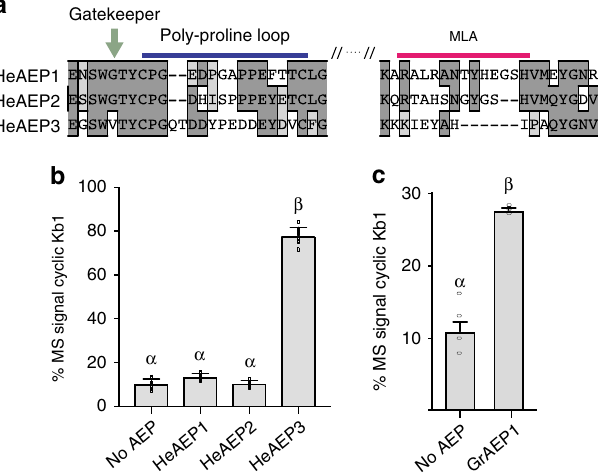
Fig. 7 The MLA as a diagnostic marker for the discovery of ligase-type AEPs. a Sequence alignment of H. enneaspermus AEPs (see also Supplementary Fig. 11). HeAEP3 was predicted to be a ligase due to the truncation within the MLA and the presence of a unique Gatekeeper residue. b , c MALDI-MS analysis of N. benthamiana -produced peptides upon co-expression of ( b ) HeAEP1, 2 and 3 with Oak1 and ( c ) GrAEP1 with Oak1 . For all treatments, means and s.e.m. are of the percentage MS signal obtained for cyclic kB1 over the total MS signal of all kB1-related peptides produced. Treatments carrying unique Greek lettering are signi fi cantly different ( P < 0.05) as determined by Tukey ’ s ANOVA. Replicates are as follows: n = 8 (no AEP, HeAEP1, HeAEP2, HeAEP3) and n = 6 (GrAEP1). Error bars are s.e.m.